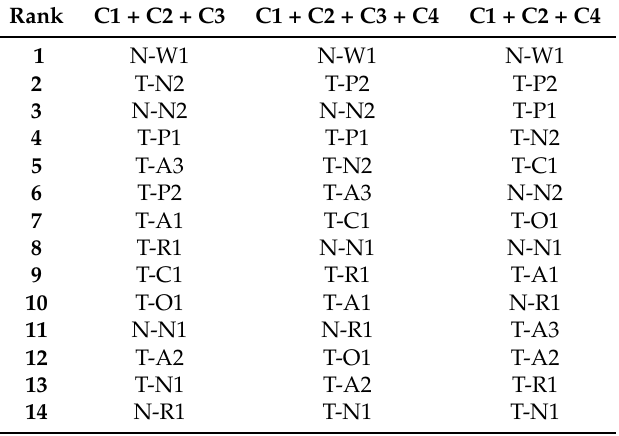
Table 3. Comparison between three solutions of a MCDA if different criteria are